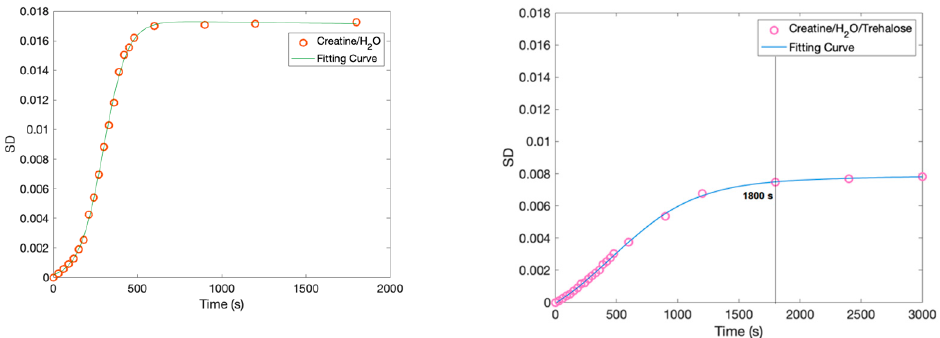
Figure 7. SD calculated values versus time for the creatine aqueous solution on the left and for the creatine aqueous solution in the presence of trehalose on the right .